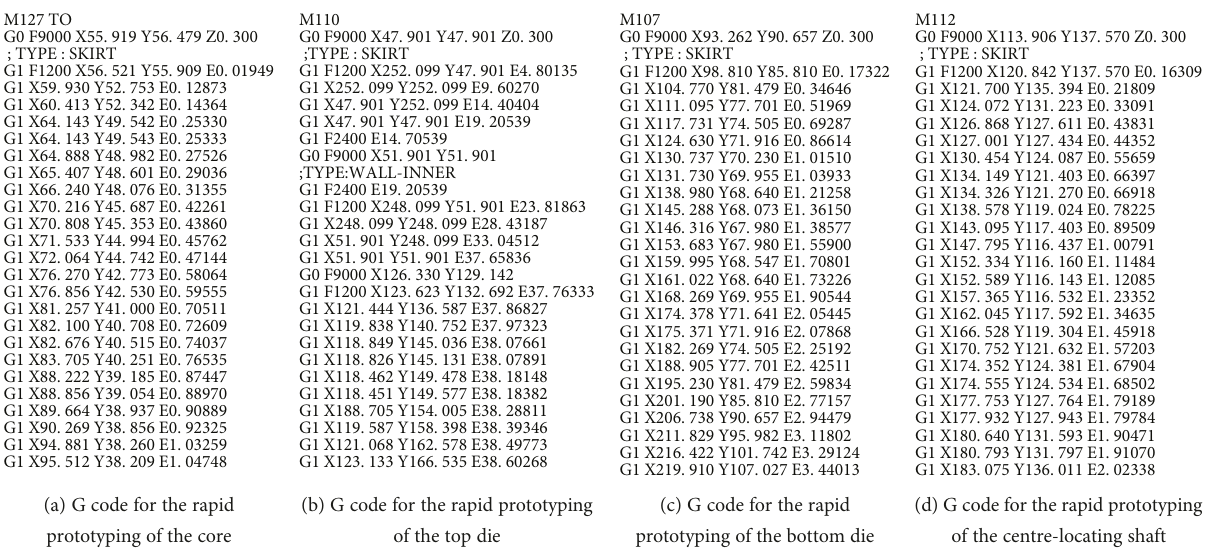
Figure 13: The results of the strati fi ed slice processing for the spur face gear model.